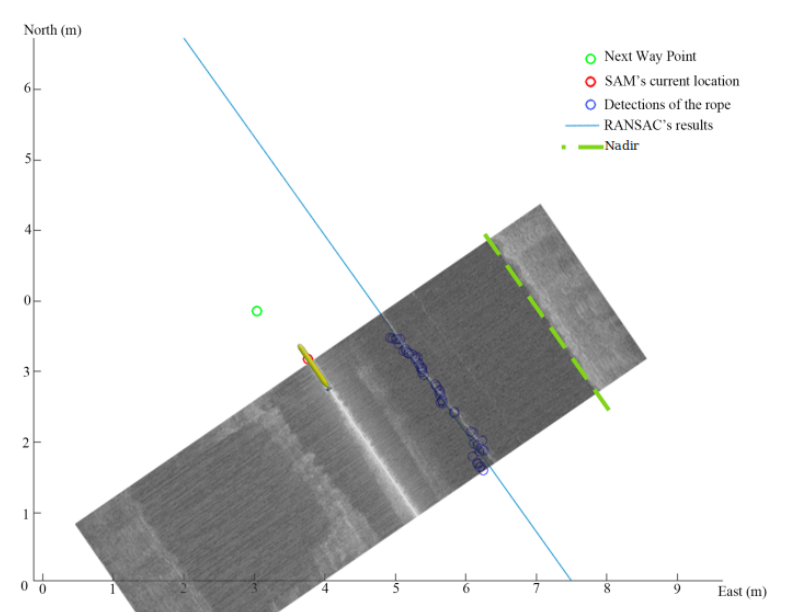
Figure 9. We show how the detections of the rope in the figure are accumulated and fit to a straight line which can then be used to send an offset line to the